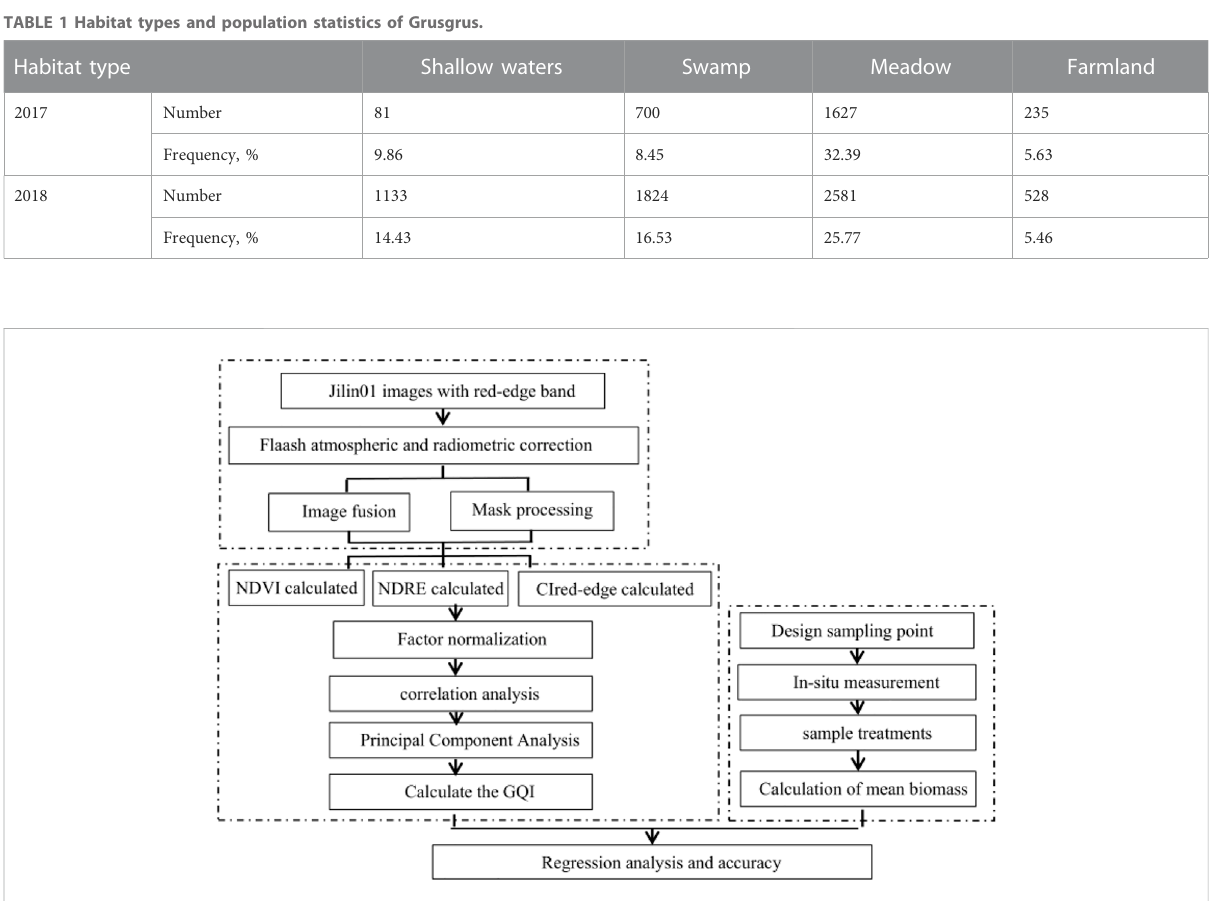
FIGURE 2 The overall methodological fl owchart for evaluation of the grassland